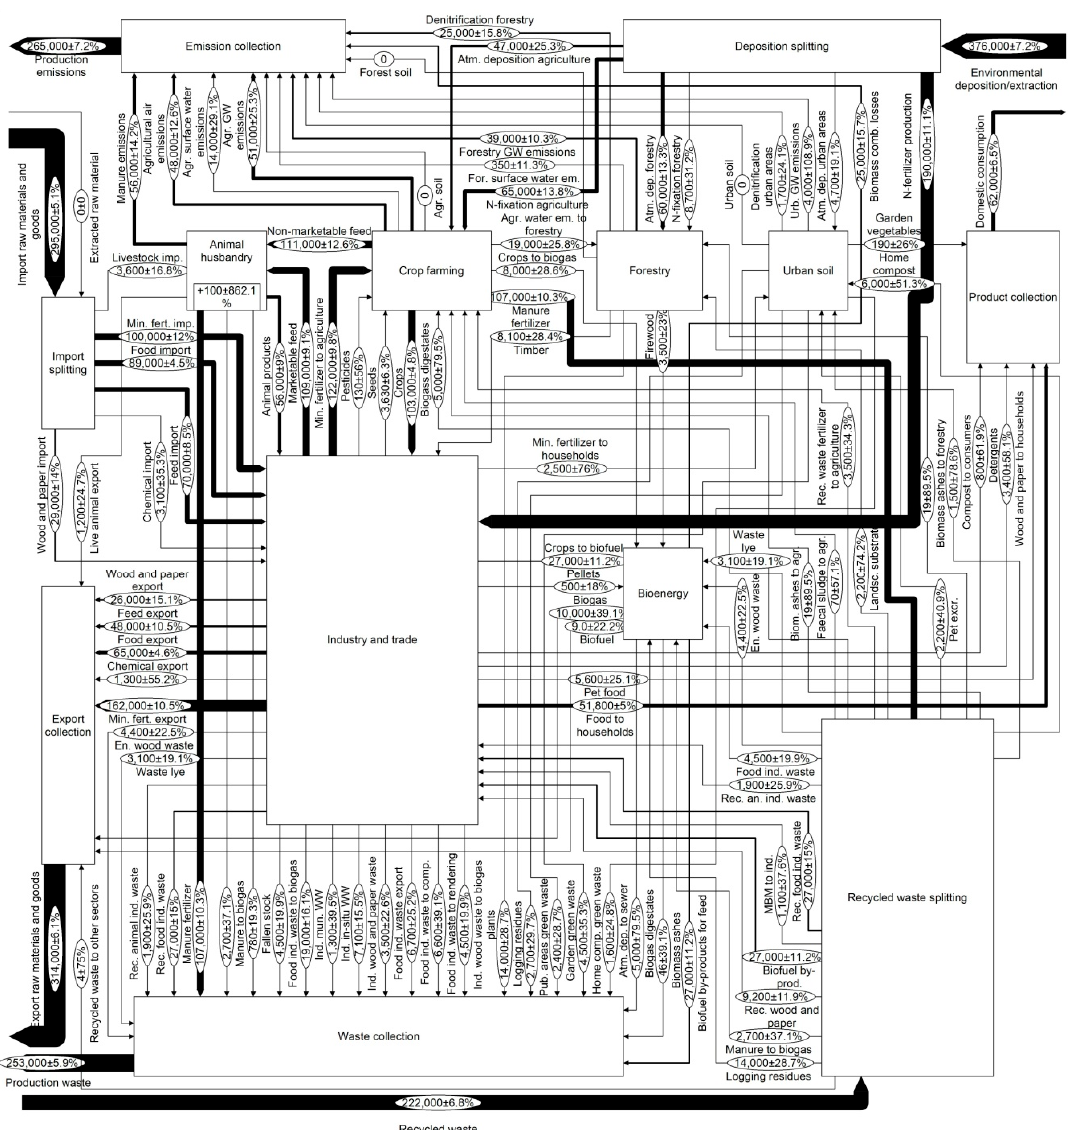
Figure A4. Austrian N system 2015, subsystem production.